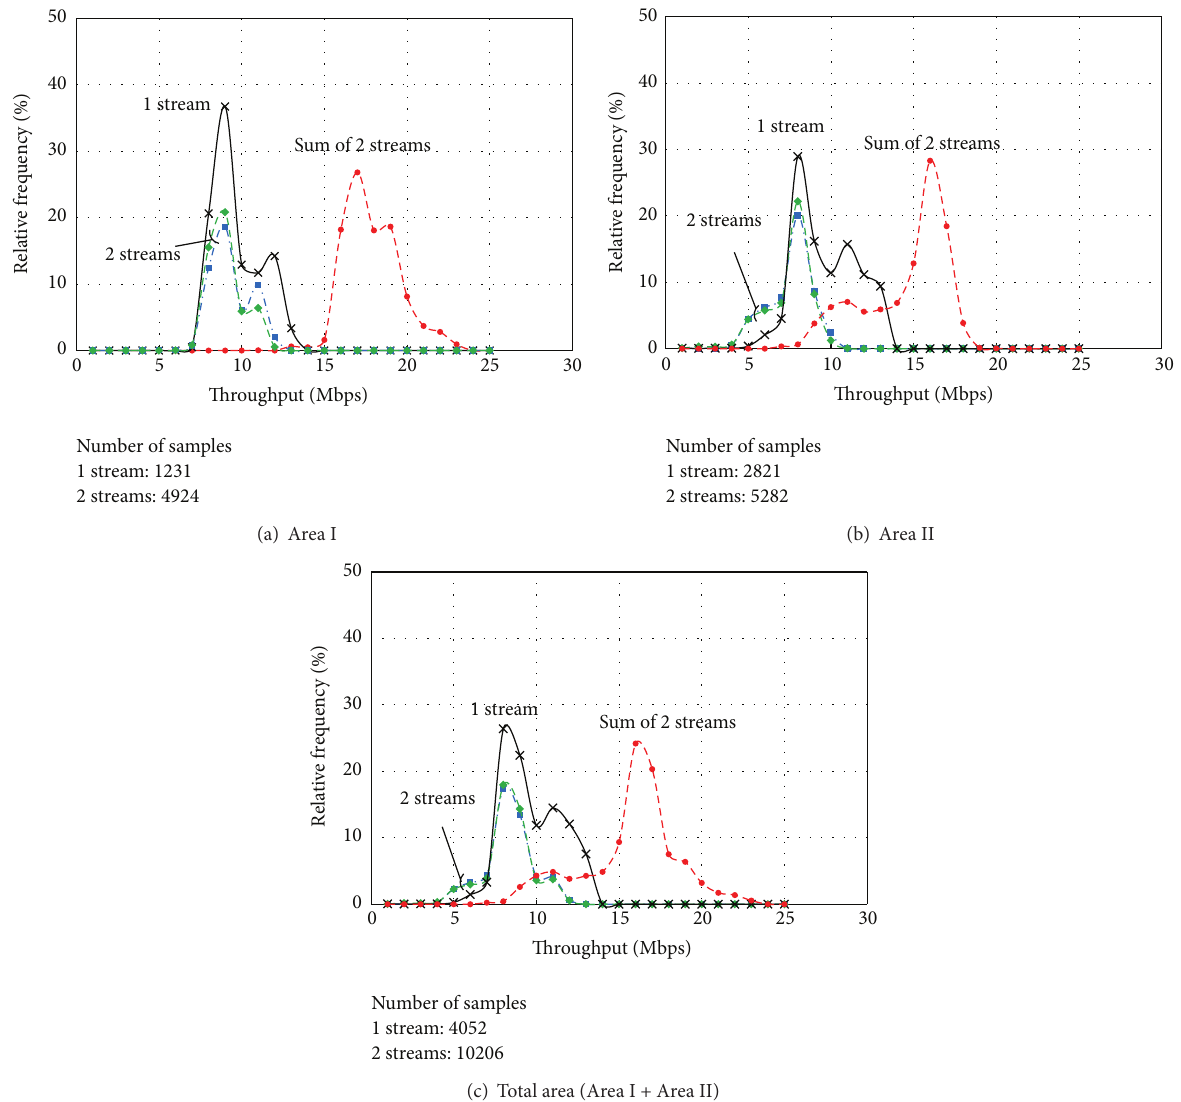
Figure 10: Throughput performance distribution in accordance with areas and number of